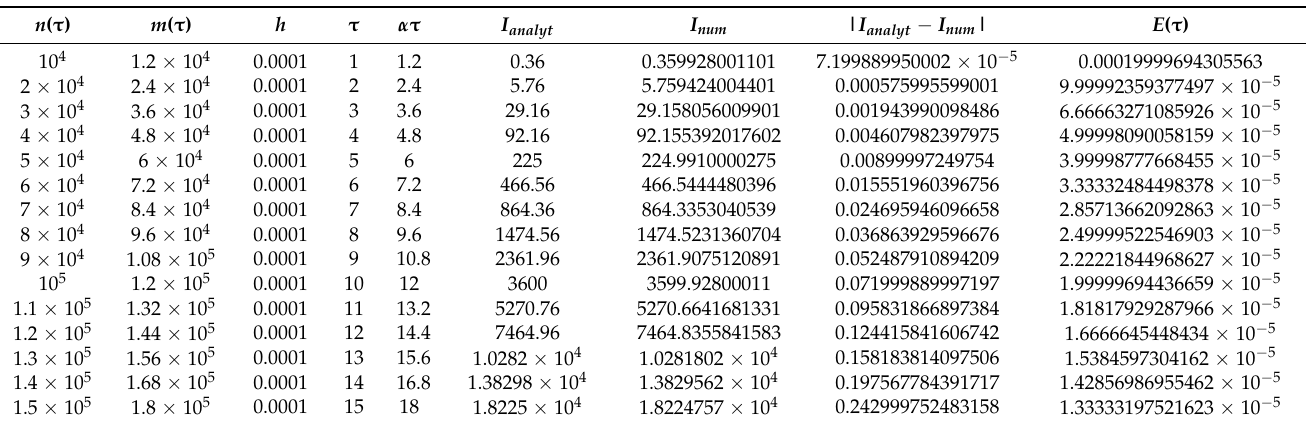
Table 14. Calculation of integral